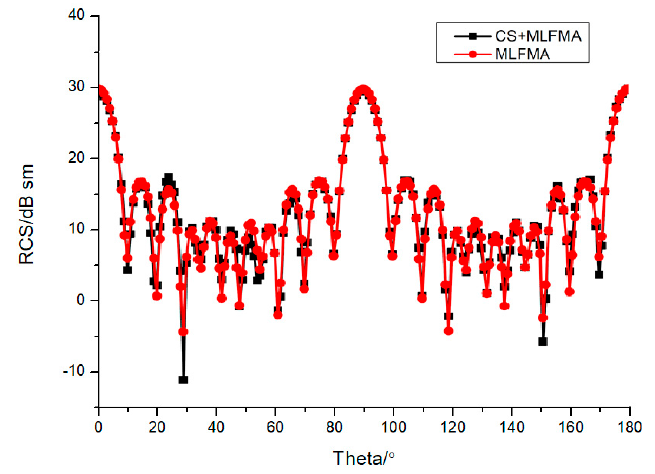
Figure 6. Radar cross section (RCS) for PEC cube by MLFMA and CS-MLFMA.